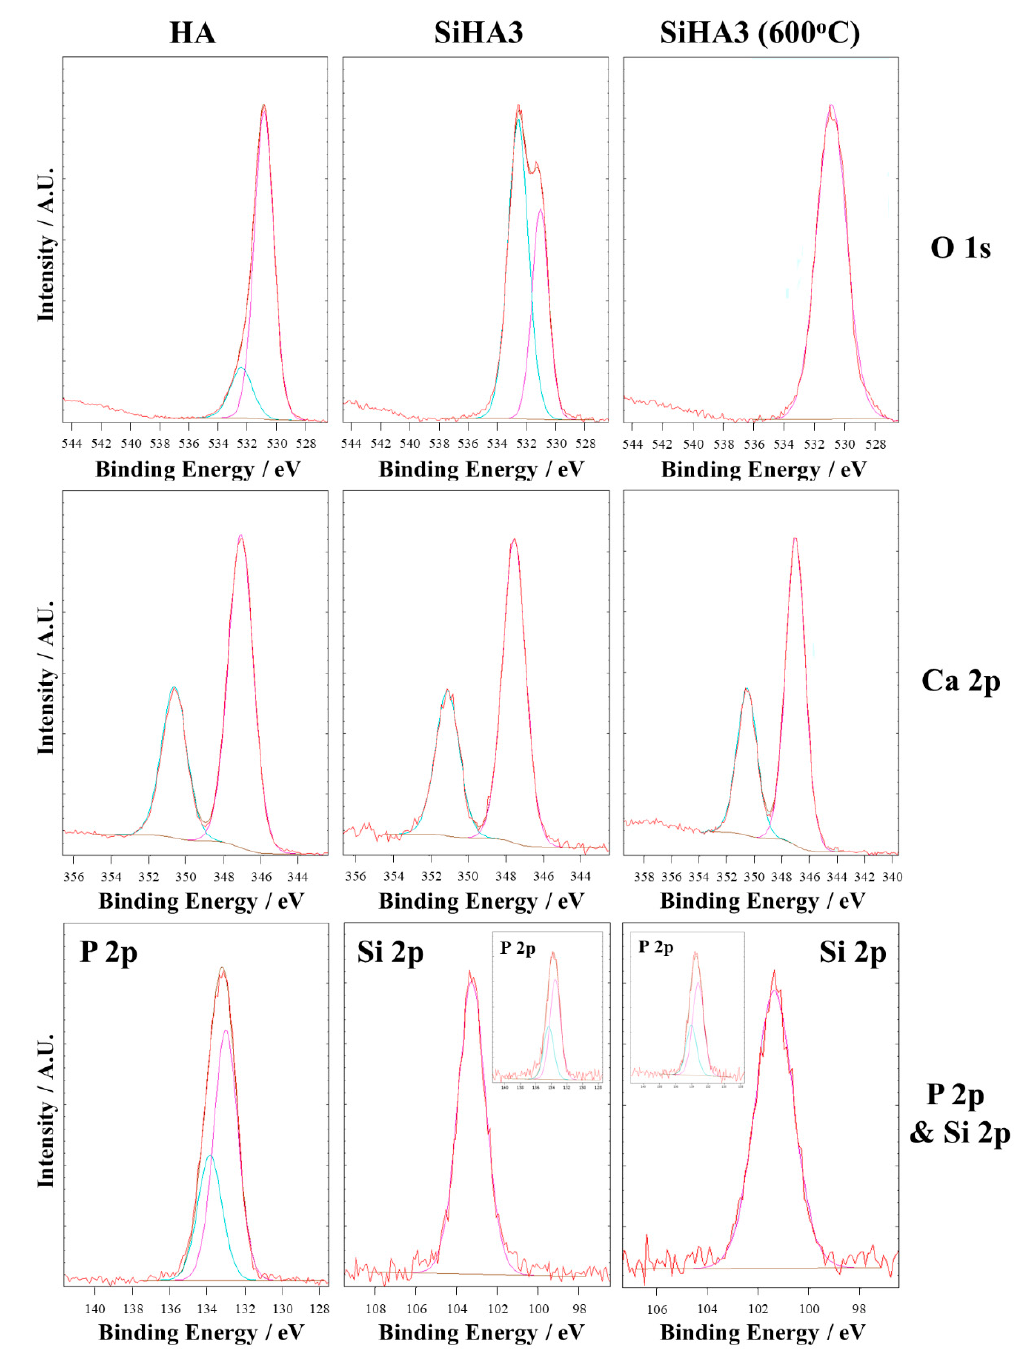
Figure 6. Representative high-resolution XPS spectra for HA, SiHA3 and 600 ◦ C annealed SiHA3 samples, demonstrating the binding energy data for O 1s, Ca 2p, P 2p and Si 2p spectra, where appropriate.